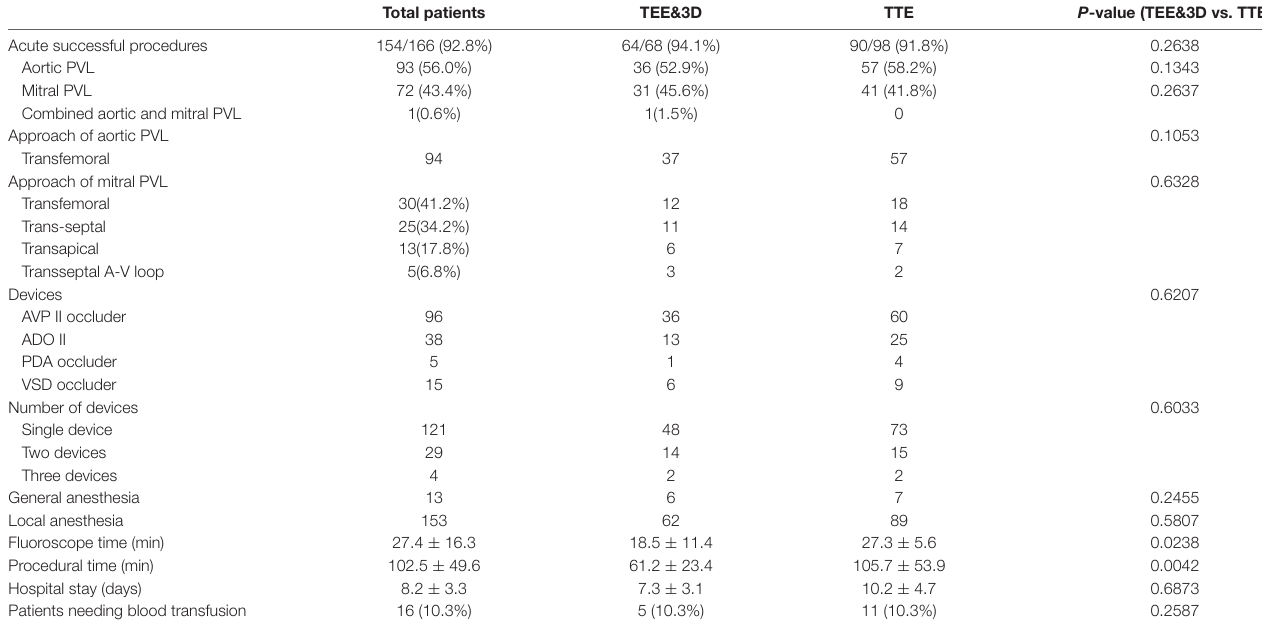
TABLE 2 | Procedural characteristics of the transthoracic echocardiographic (TTE) group and the transesophageal echocardiographic (TEE) and 3-dimensional group. Total patients TEE&3D TTE P -value (TEE&3D vs. TTE) Acute successful procedures 154/166